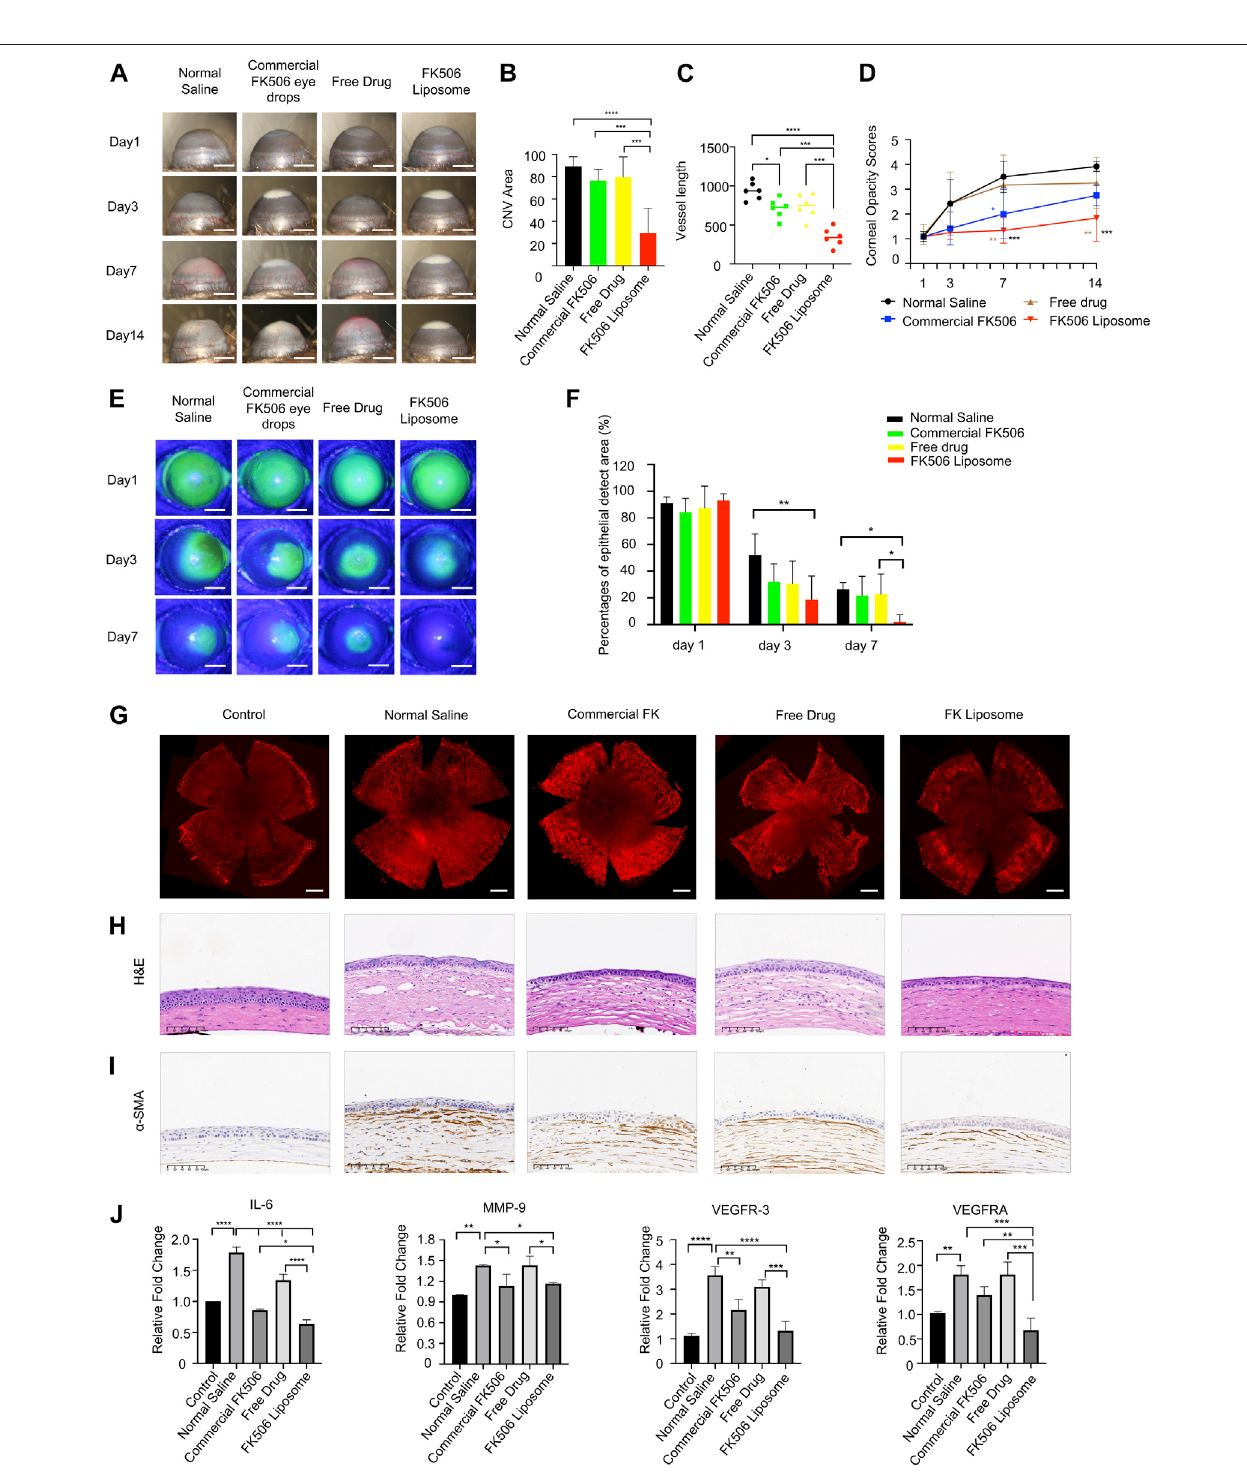
FIGURE3| Invivo therapeuticeffectevaluationofFK506liposomesinmousecornealalkaliburnmodel. (A) Slit-lampexaminationofCoNVonthe1st,3rd,7th,and 14th days after corneal alkali burn. Scale bar: 1 mm. (B) Quanti fi cation of the CoNV area ( n (cid:2) 6). (C) Quantitative analysis of the corneal vessel length ( n (cid:2) 6). (D) The corneal opacity score on the 14th day of treatment ( n (cid:2) 6). (E) The corneal sodium fl uorescein staining areas in each treatment group on days 1, 4, and 7 (scale bar: 1 mm)andtheir (F) quantitativeanalysis( n (cid:2) 6). (G) CD31vascularendothelialmarkerimmuno fl uorescencestainingonday14.Scalebar:500 μ m. (H) H&Estaining and (I) α -SMA IHC staining of corneal sections after treatment with various formulations for 14 days. Scale bars: 100 μ m. (J) The expressions of vascular endothelial growth factors (VEGF-A, VEGFR-3) and in fl ammatory factors (IL-6, MMP-9) in the corneas of each treatment group on the 14th day ( n (cid:2) 3). The data was presented as mean ± SD, one-way ANOVA, * p < 0.05, ** p < 0.01, *** p < 0.001, and **** p < 0.0001.